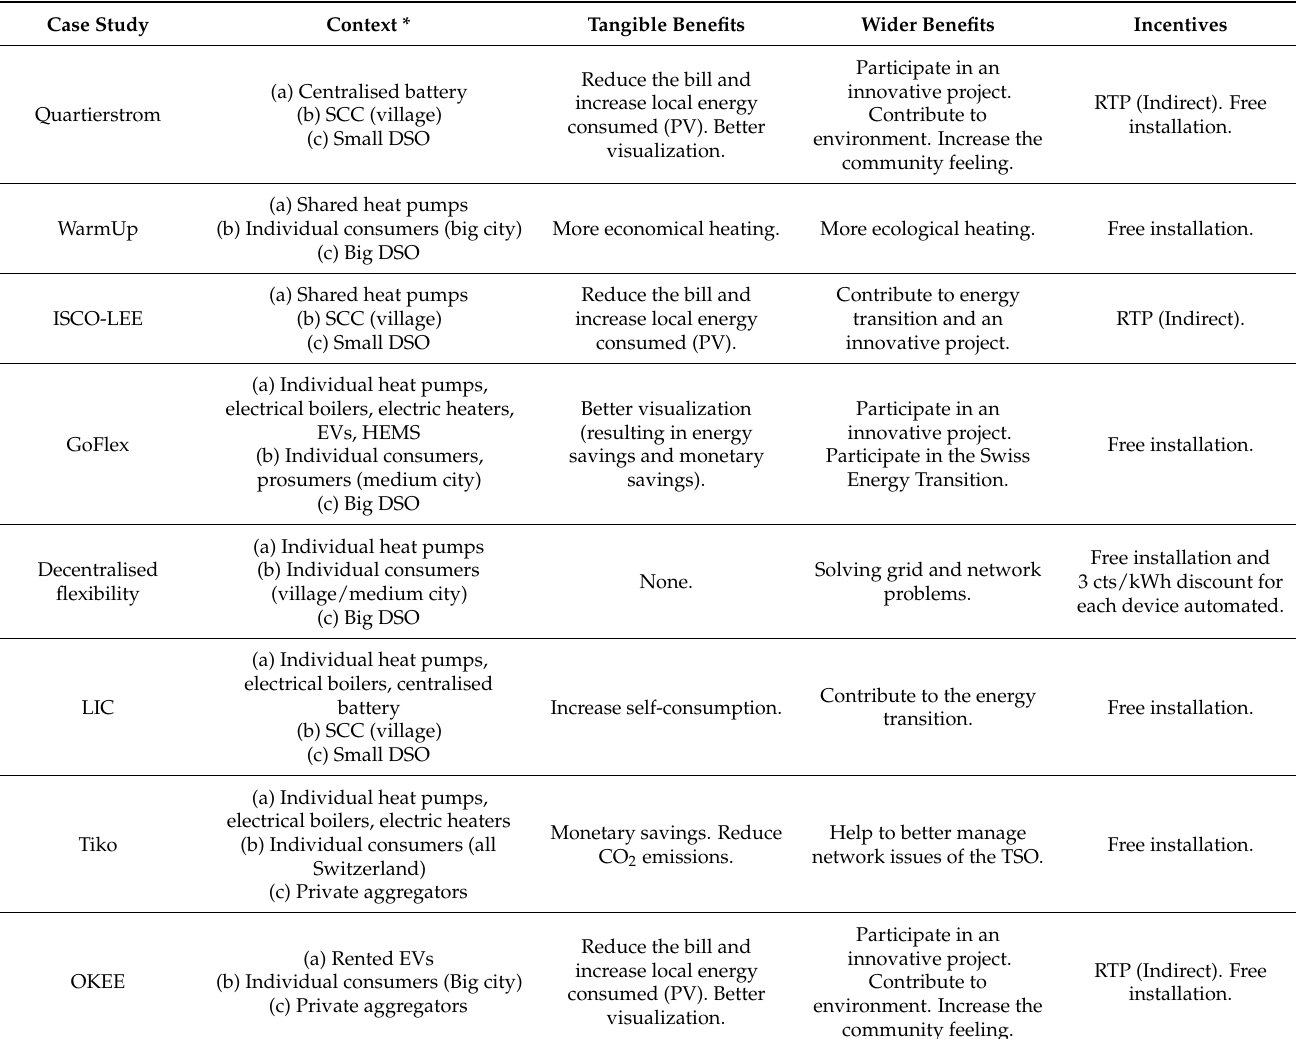
Table 3. Benefits and incentives presented to the